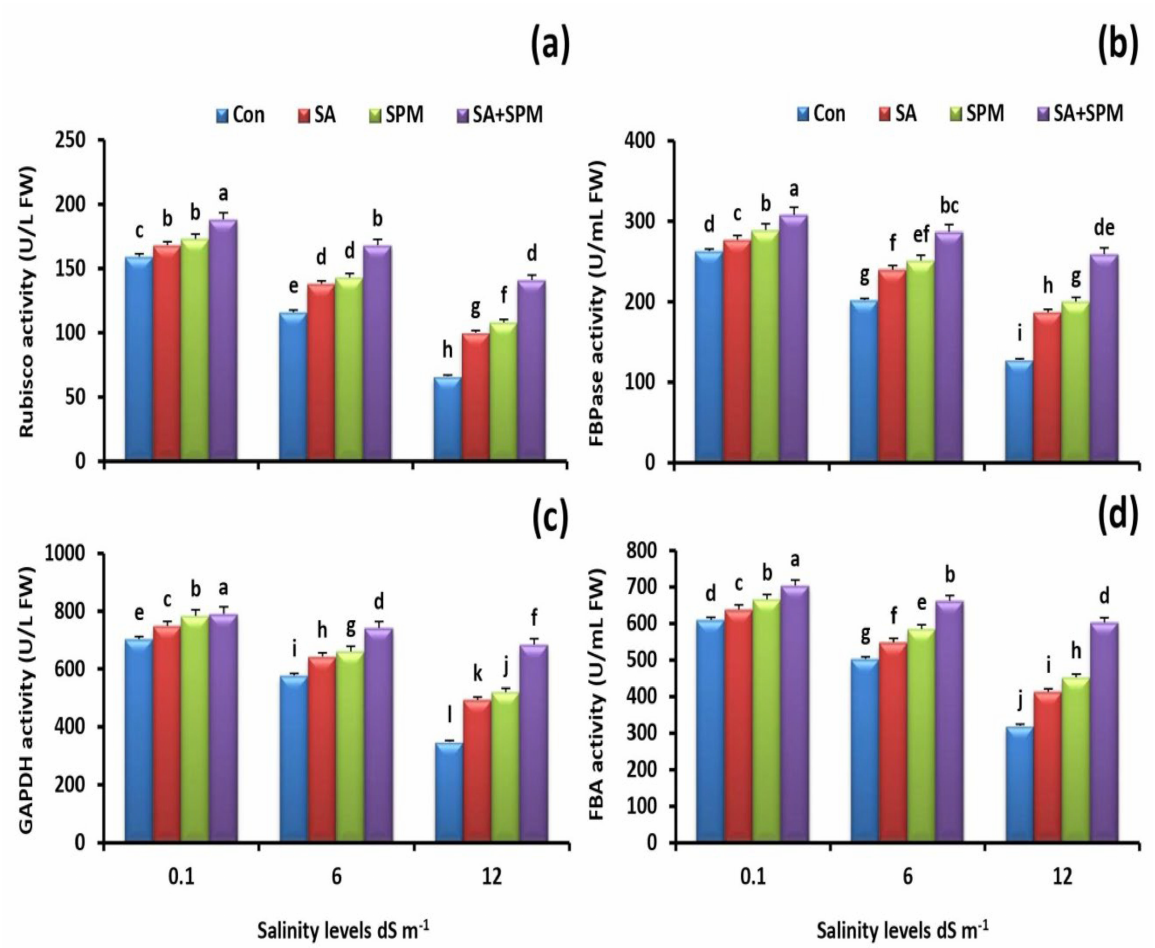
Figure 2. Effect of salicylic acid (SA) and/or spermine (SPM) foliage applications on the activity of ( a ) ribulose diphosphate carboxylase/oxygenase (Rubisco), ( b ) fructose 1,6-bisphosphatase (FBPase), ( c ) glyceraldehyde-3-phosphate dehydrogenase (GAPDH), and ( d ) fructose 1,6-bisphosphate aldolase (FBA) in leaves of wheat plants exposed to non-saline and saline (6.0 and 12.0 dS m − 1 ) conditions. The results showed the mean ± SE of four replicates. Different letters indicate significant differences at ( p < 0.05) level according to Duncan’s